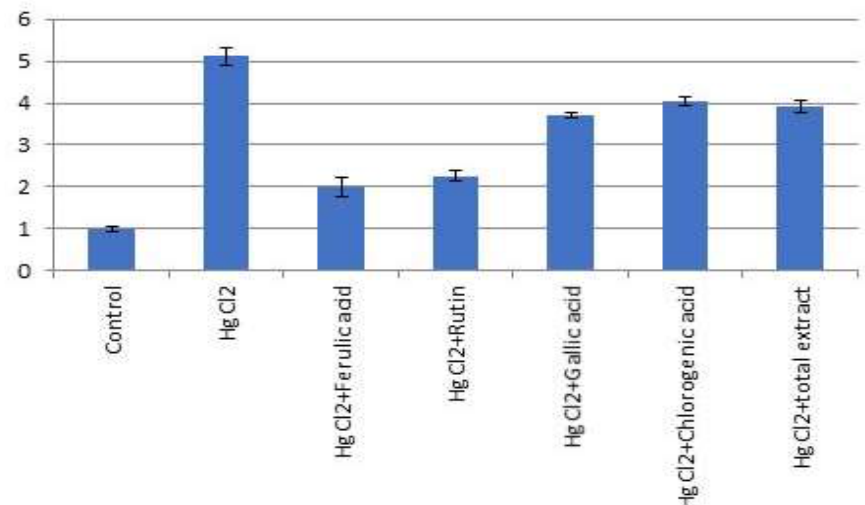
Figure 8. Effect of P. dioica aqueous extract and its isolated bioactive compounds on lung miRNA 155 expression in rats. Data ( n = 10 per group) are presented as fold of control considering the normal control one.